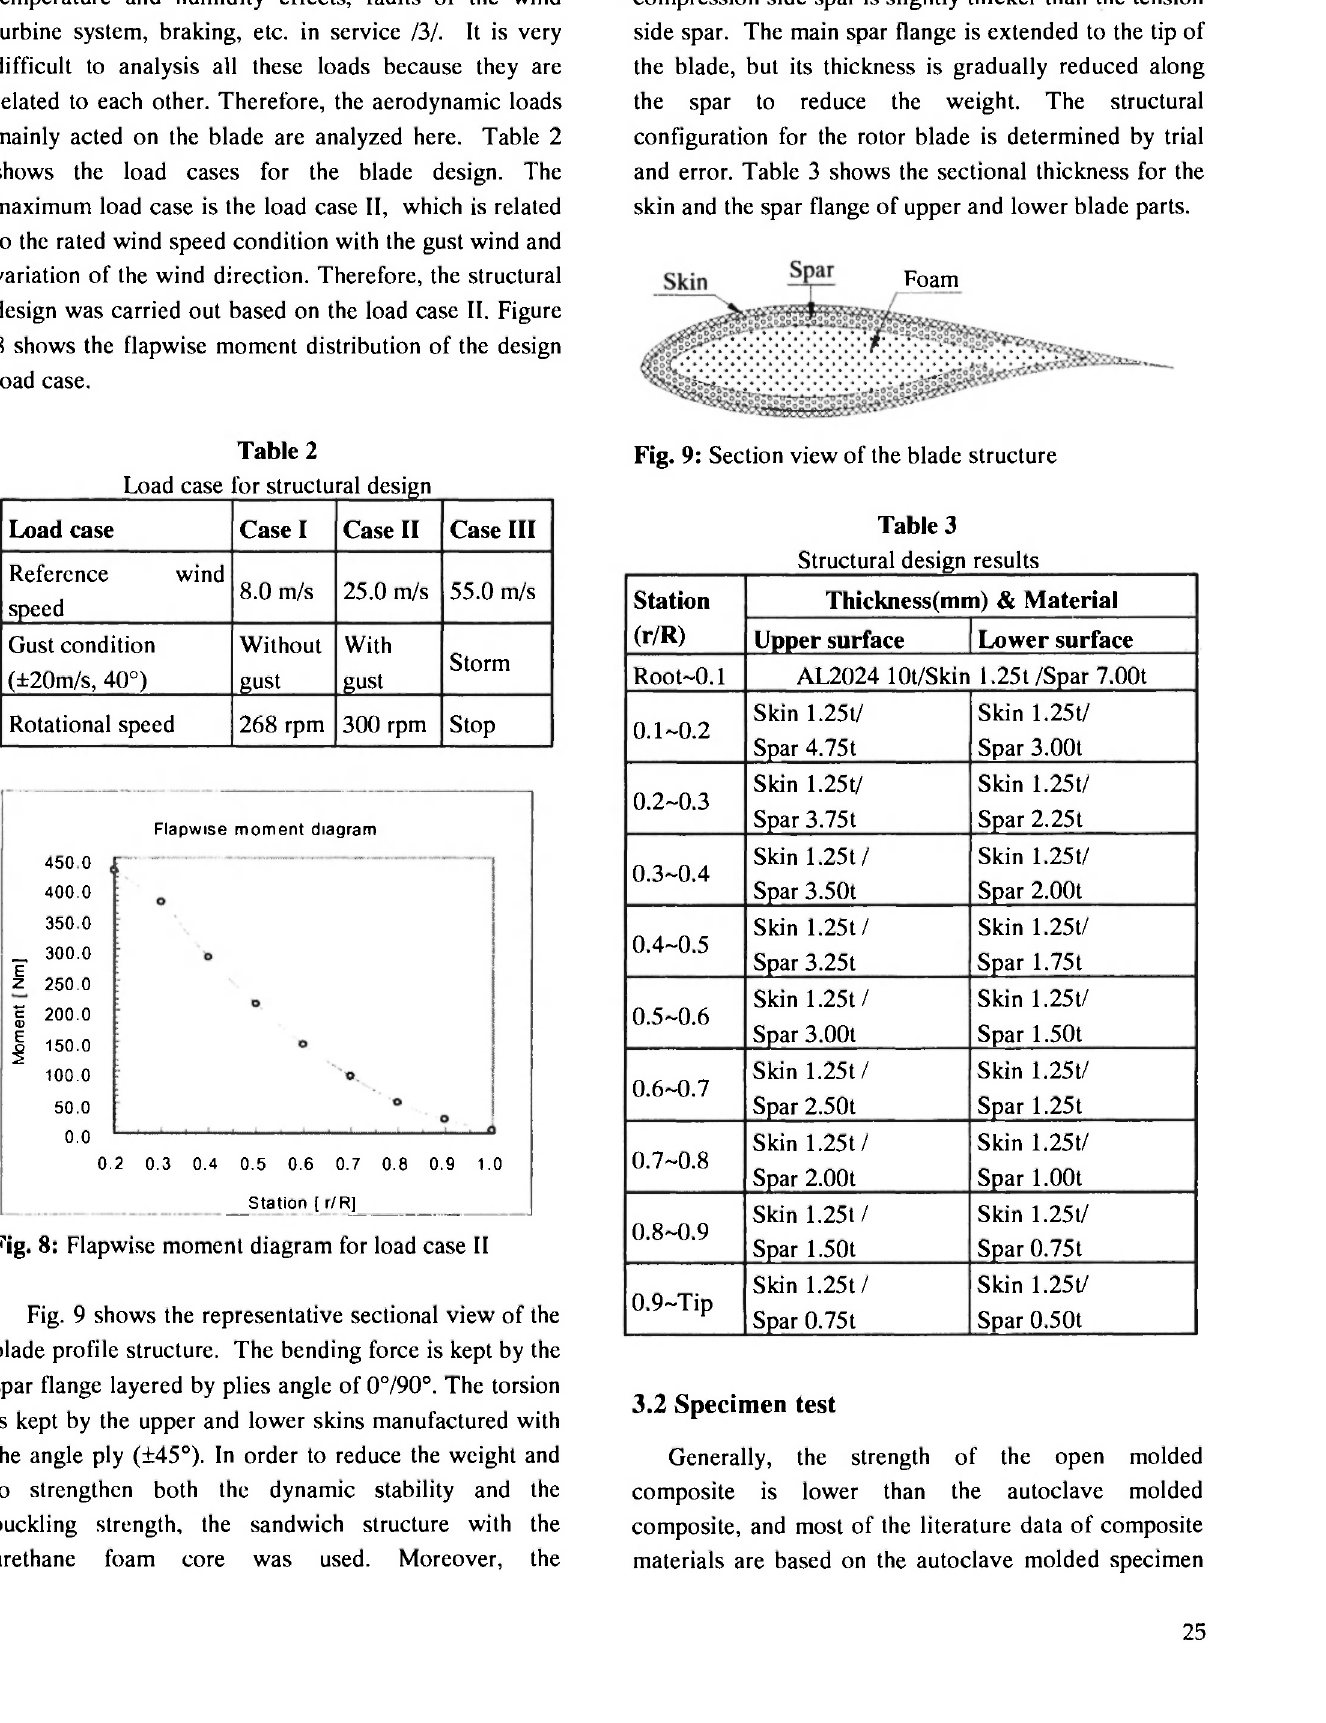
Fig. 9: Section view of the blade